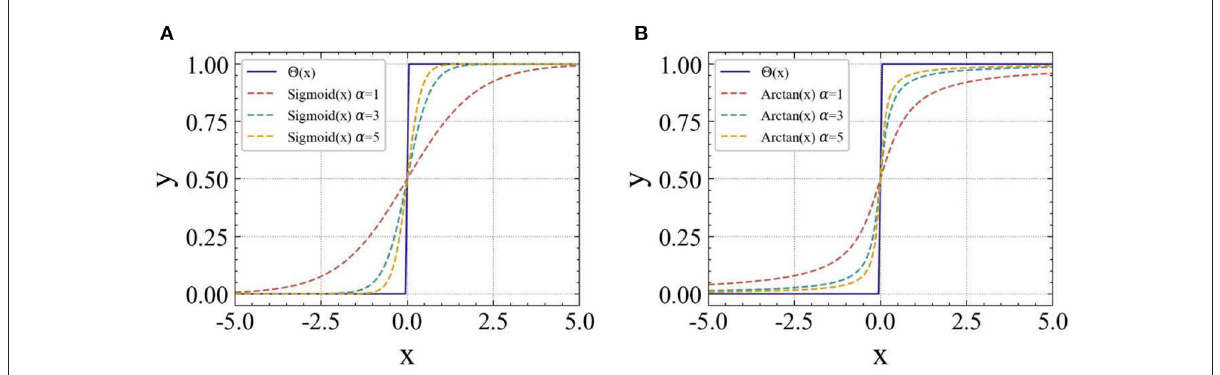
FIGURE6 Comparison of the surrogate gradient function and Heaviside step function 2 ( x ) for the different values of α . (A) Smoothed Sigmoid function, (B) Smoothed Arctan